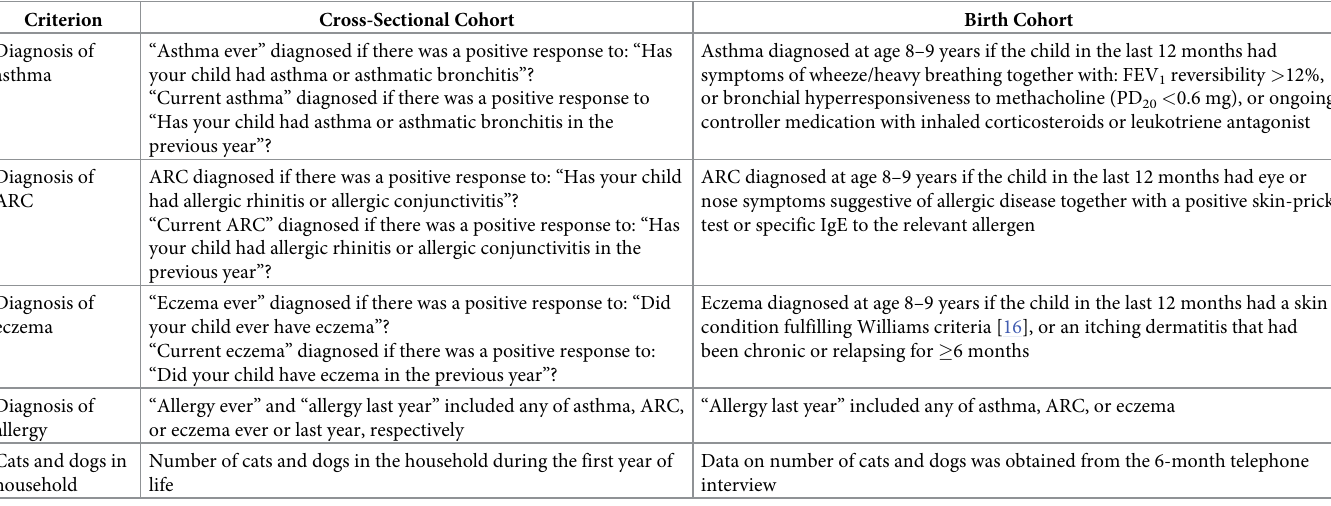
Table 1. Diagnostic criteria and information on pet exposure in the Cross-Sectional Cohort and Birth Cohort.